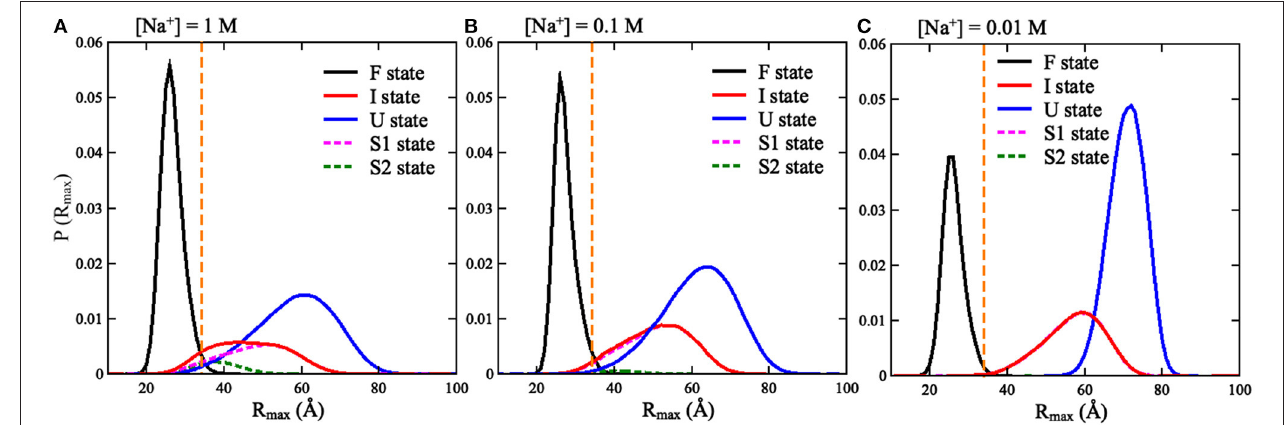
FIGURE 5 | The distributions of R max for the three states (F, I, and U) of the mouse mammary tumor virus (MMTV) pseudoknot over the conformations at all temperatures and different [Na + ]’s: (A) 1M [Na + ], (B) 0.1M [Na + ], and (C) 0.01M [Na + ]. The vertical dashed lines in (A–C) represent R max = 35